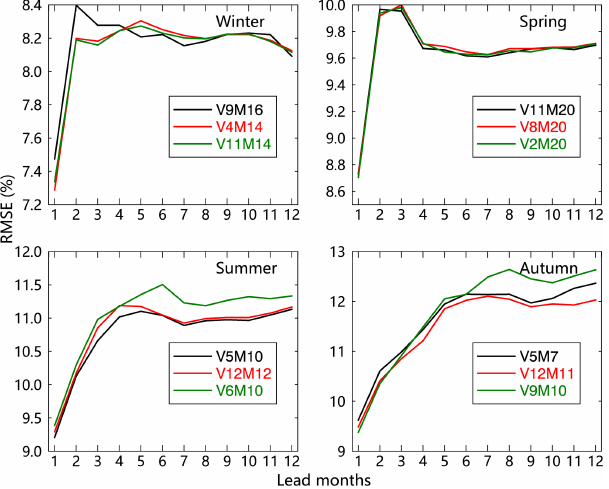
Figure 5. Same as Fig. 4 but for